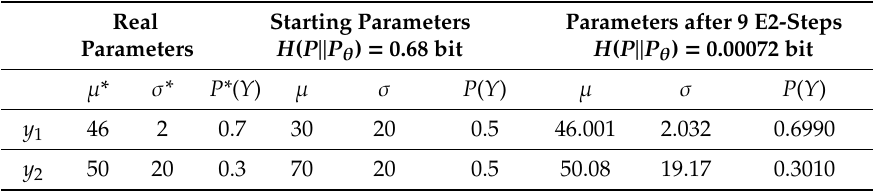
Table 4. True and guessed model parameters and iterative results of Example